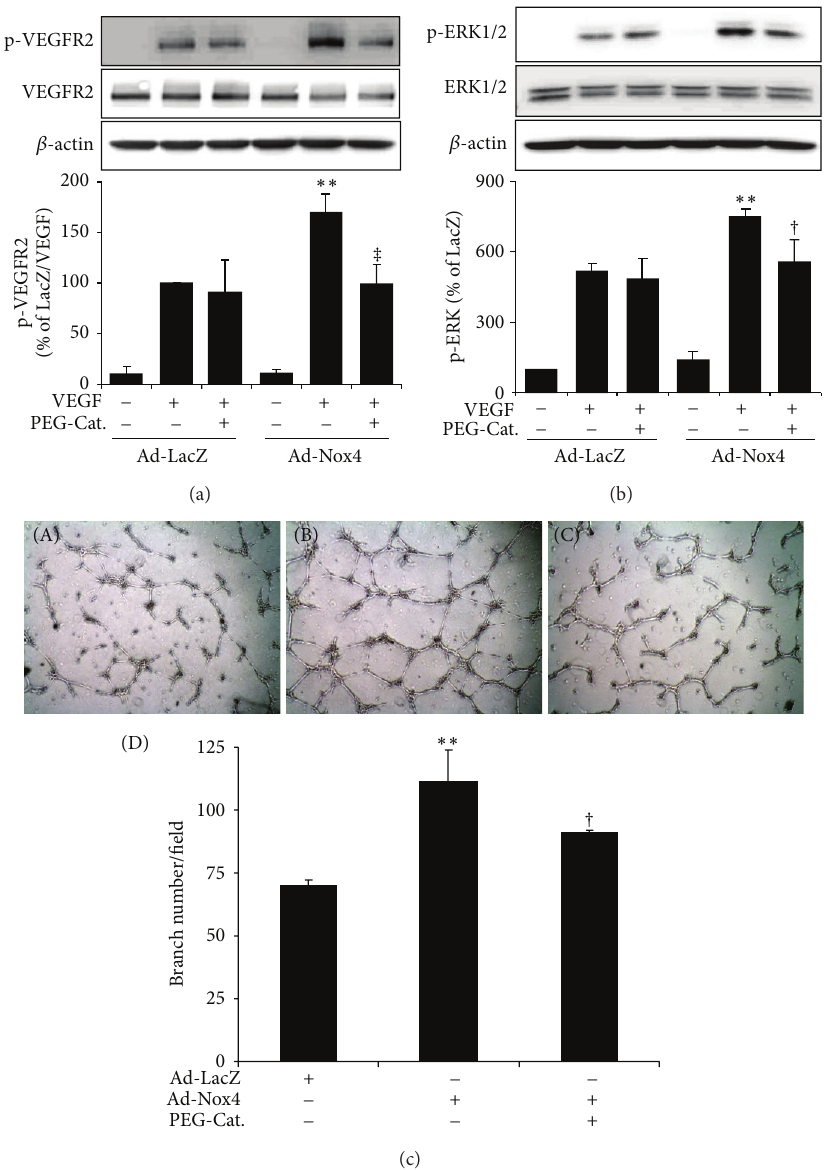
Figure5:ScavengingofNox4-derivedH 2 O 2 attenuatedVEGFR2activationandreducedendothelialtubeformation.HRECsweretransduced with Ad-LacZ and Ad-Nox4 for 48 h and then incubated with PEG-Catalase at dose of 1000U/mL for 16h. (a-b) Phosphorylation of VEGFR2 (a)andERK(b)inducedbyVEGF(50 ng/mL)wasdeterminedbyWesternblotanalysisandsemiquantifiedbydensitometry. 𝑛 = 4 ; ∗∗ 𝑃 < 0.01 versus Ad-LacZ with VEGF and † 𝑃 < 0.05 or ‡ 𝑃 < 0.01 versus Ad-Nox4 with VEGF. (c) Tube formation capacity of HRECs was evaluated by Matrigel assay. (c-A) Ad-LacZ, (c-B) Ad-Nox4, (c-C) Ad-Nox4 with PEG-Cat, and (c-D) quantification of tube numbers from 3 visual fields. Results represent 3 independent experiments. ∗∗ 𝑃 < 0.01 versus Ad-LacZ; † 𝑃 < 0.05 versus